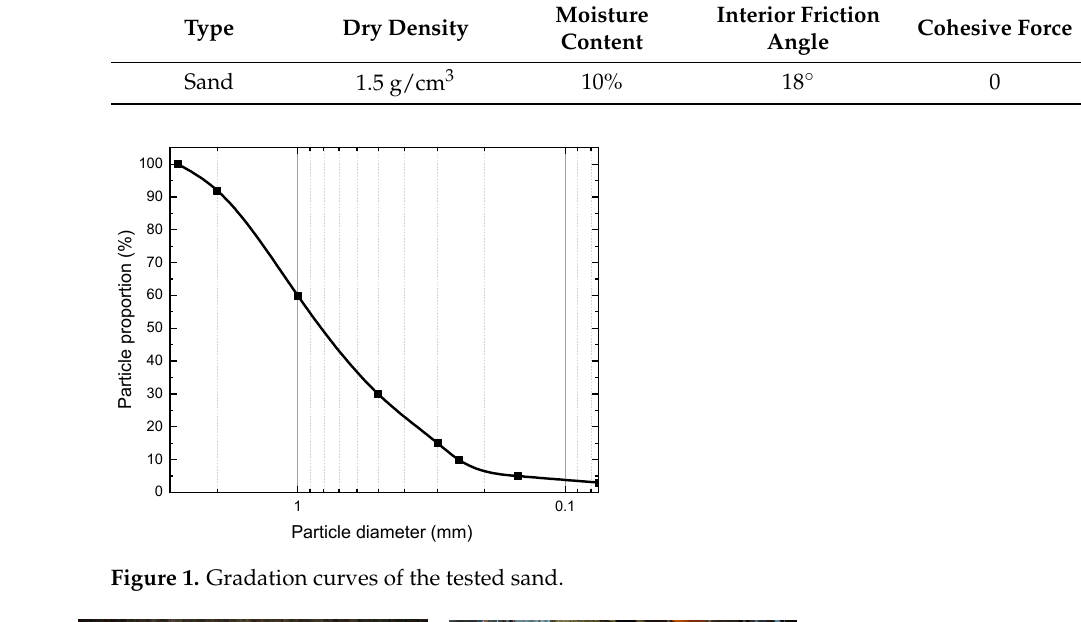
Table 1. The Gaussian fitting results for three energy levels.